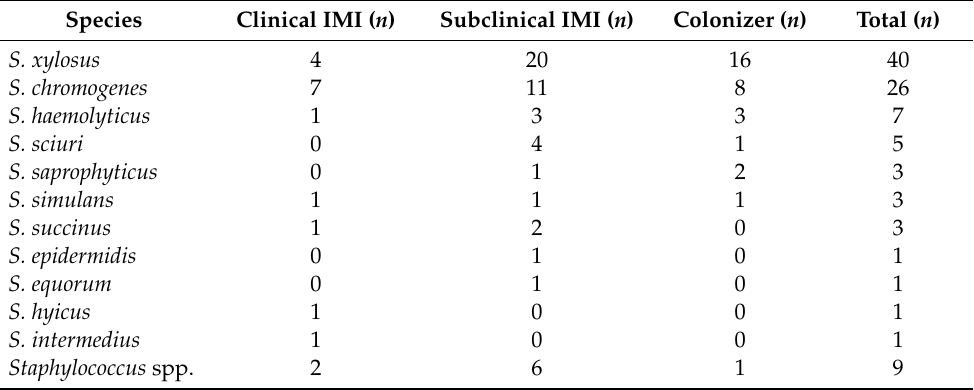
Table 3. Distribution of coagulase-negative staphylococci species in relation to their